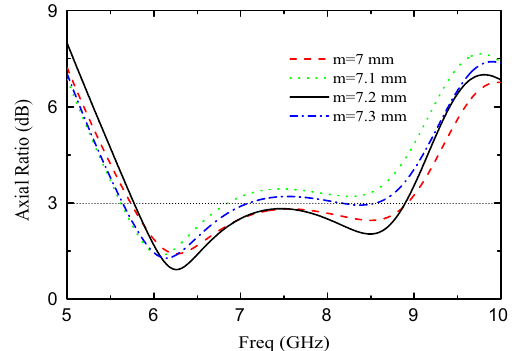
Fig. 8 Influence of antenna ground plate length m on antenna AR performance